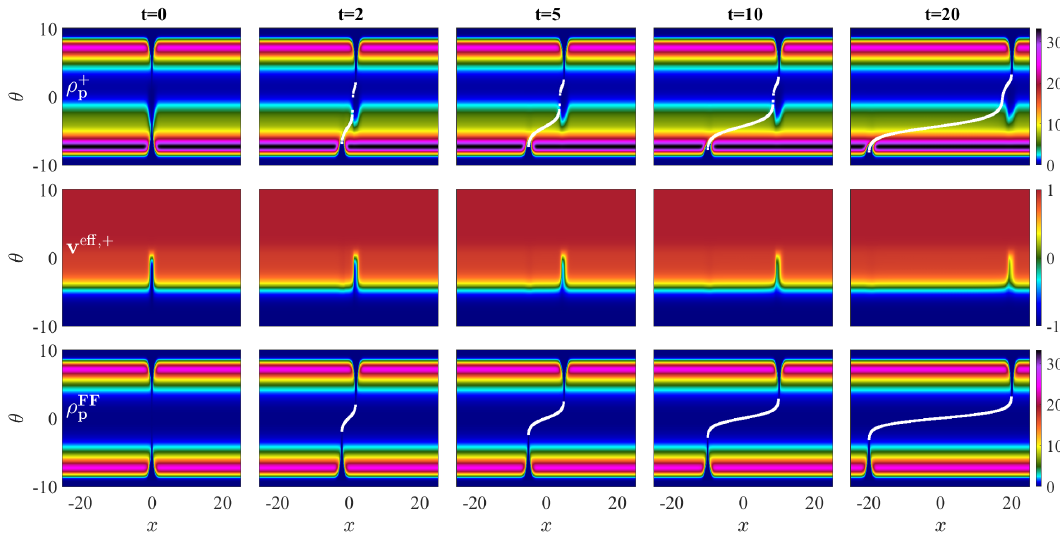
Figure 13 . Spectral density of particle + (row 1) and its effective velocity (row 2) in the case of an inverted gaussian profile with log(2 T ) = 4 and T = 0 . The white curve superimposed to figures a m in row 1 is the function v eff , + ( x, t, θ ) = x which very accurately describes a narrow zero-density t region that is carried by the flow in row 1. Row 3 shows the spectral density of a free fermion for the same initial condition, where the same zero-density filament propagates with the flow and is exactly described by the equation tanh θ = x . t